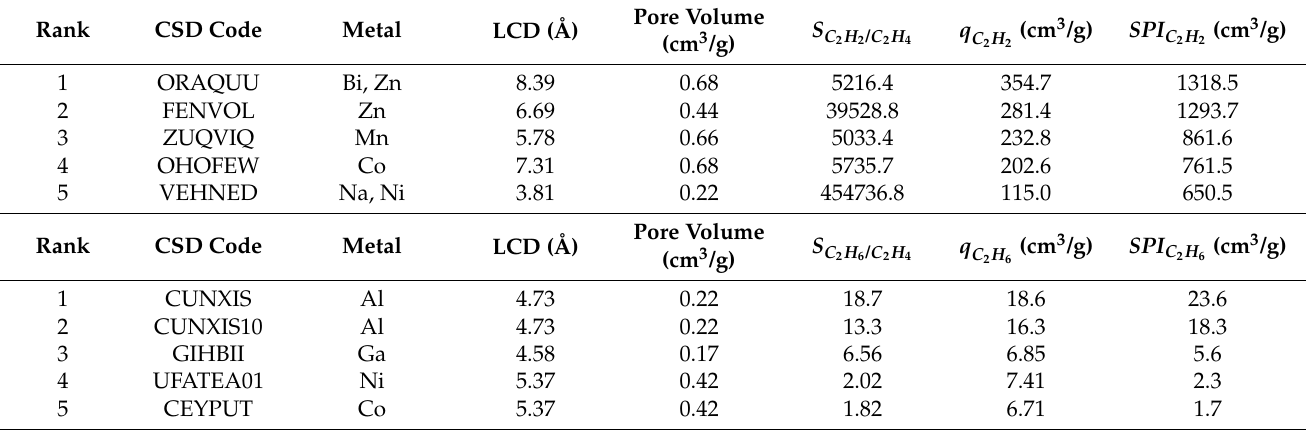
Table 4. Structural properties, selectivity, capacity, and SPI of the top five MOFs for C 2 H 2 separation (ranked according to SPI C ) as well as the top five MOFs for C 2 H 6 separation (ranked according 2 H 2 to SPI C ) for the multi-step separation of C 2 H 2 /C 2 H 4 /C 2 H 6 2 H 6